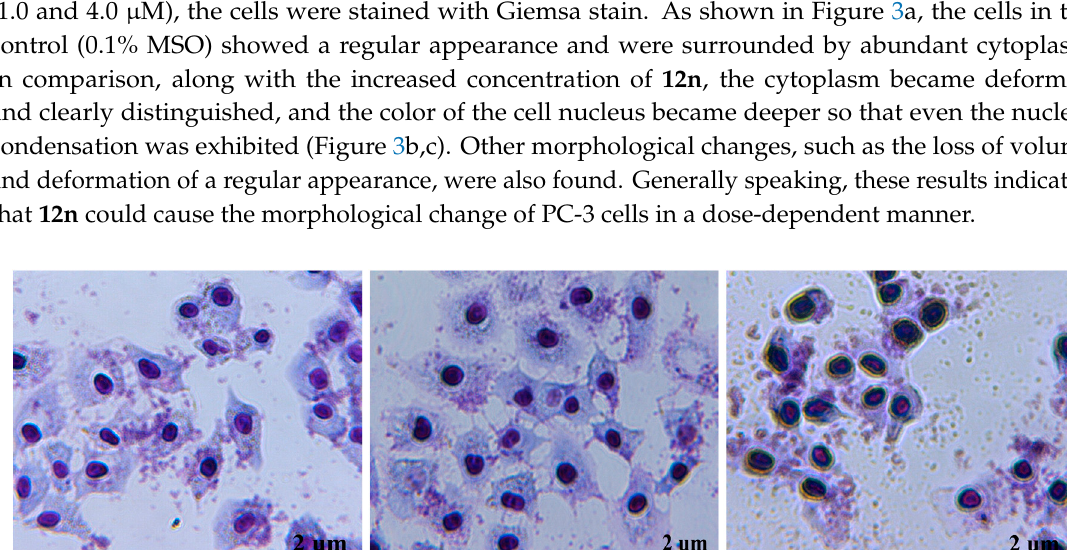
Table 3. Calculated molecular properties of all the derivatives.